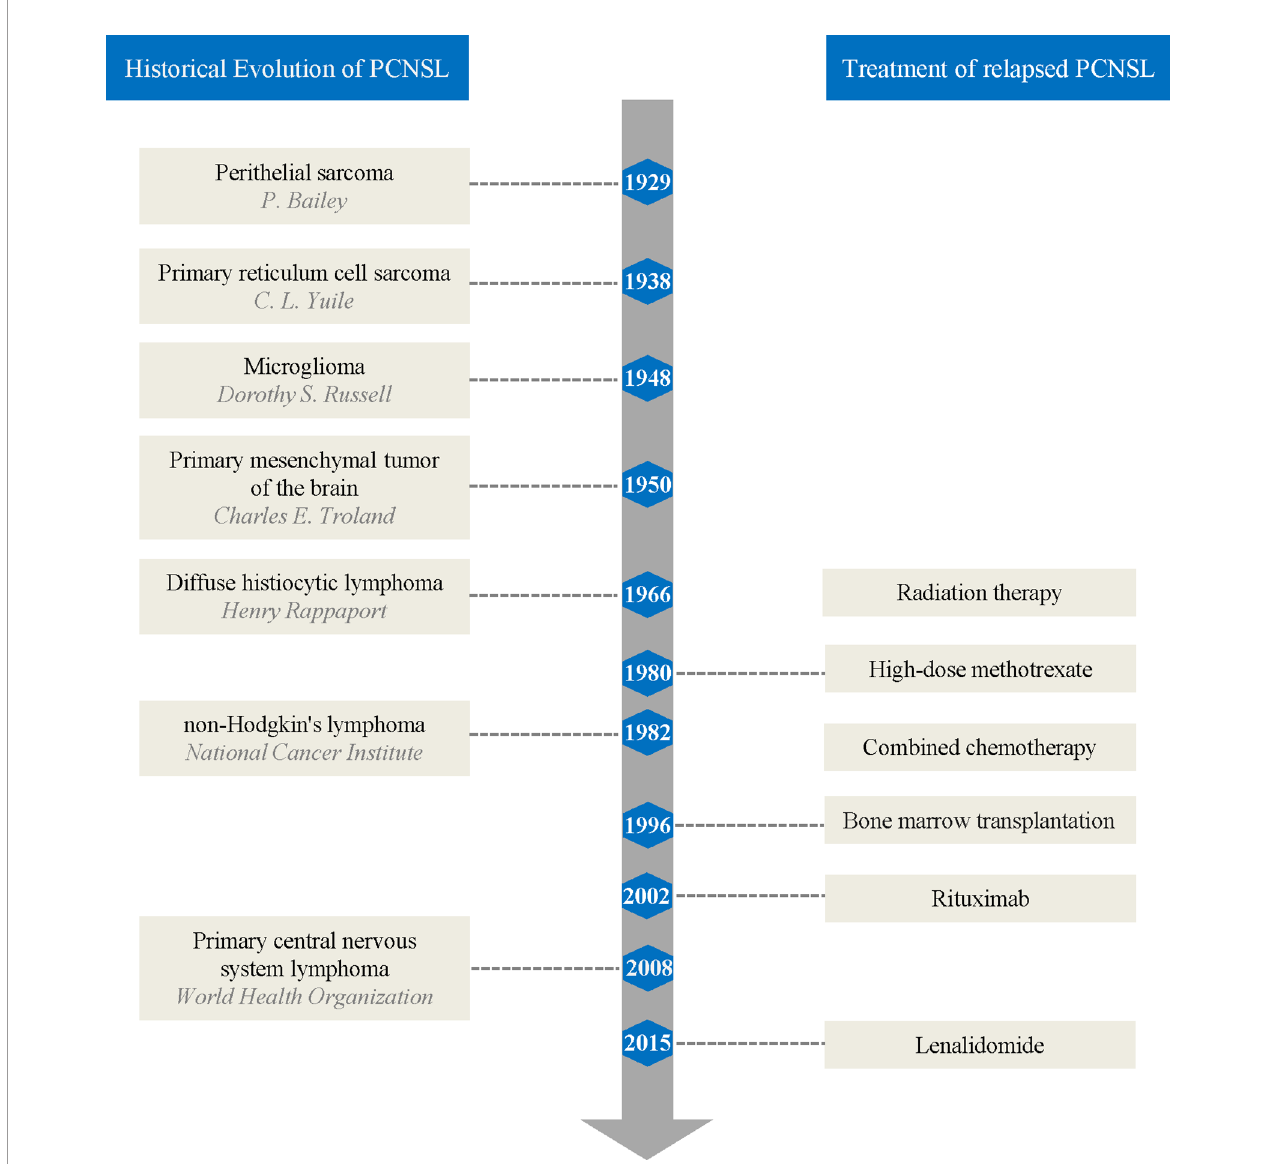
FIGURE 1 | Brief summary of primary central nervous system lymphoma history and treatment of